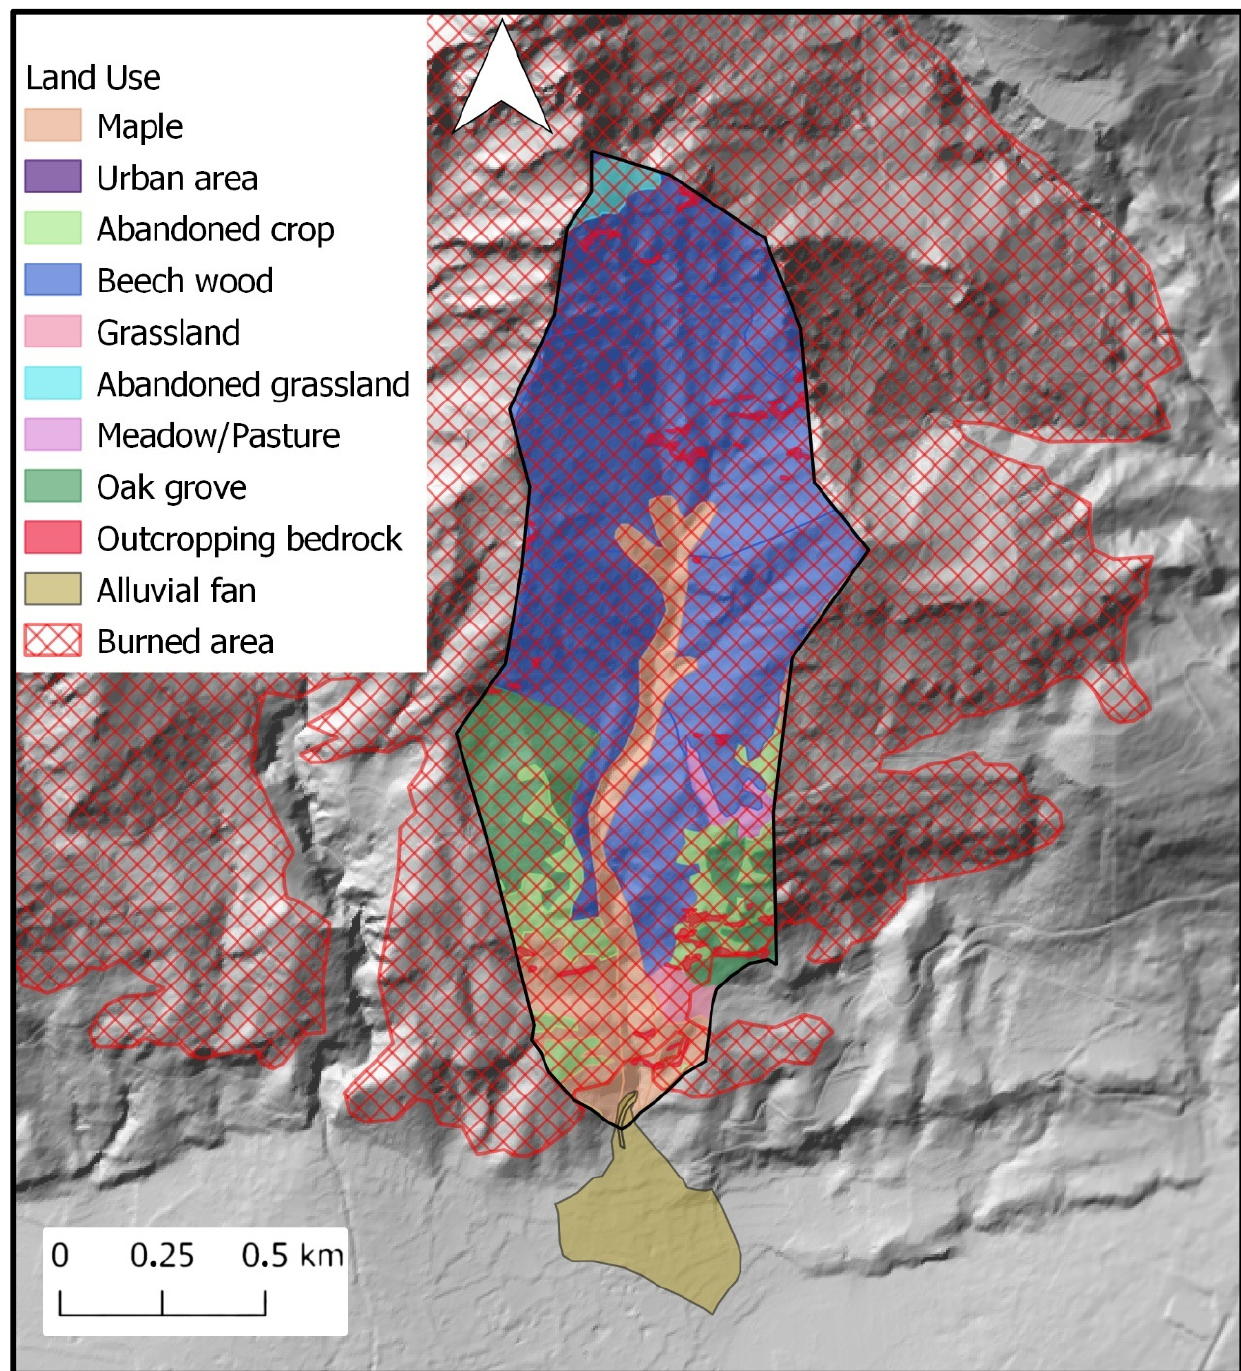
Figure 11. The Rio delle Foglie area affected by wildfire and its intersection with land use units.